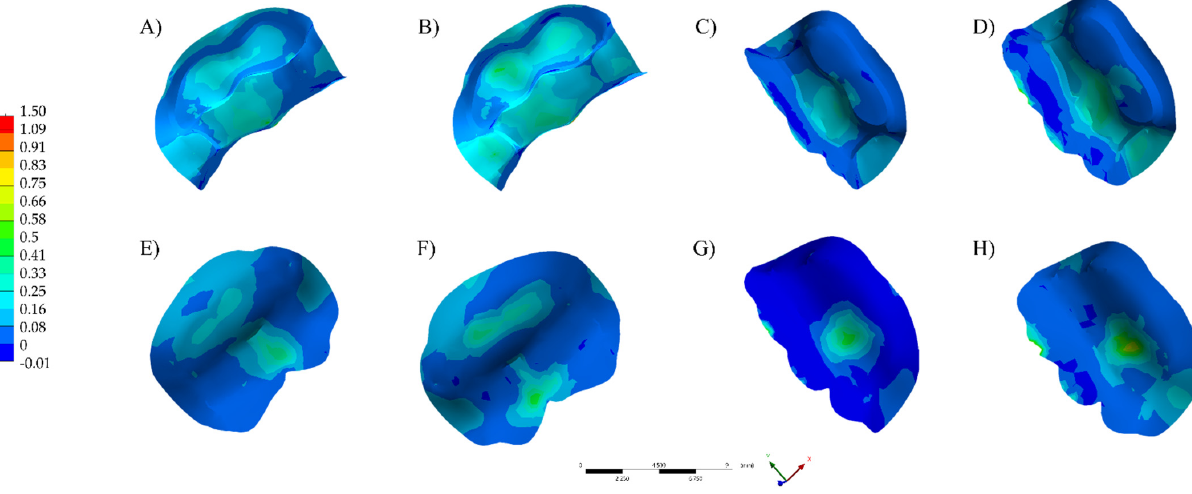
Figure 3. Maximum principal stress distribution in the cement layer. ( A ) LD TFC. ( B ) RC TFC. ( C ) LD TNFC. ( D ) RC TNFC. ( E ) LD NFC. ( F ) RC NFC. ( G ) LD NNFC. ( H ) RC NNFC.